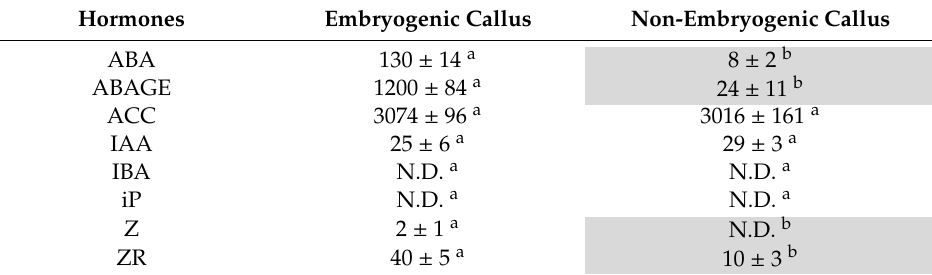
Table 7. Hormone levels in embryogenic and non-embryogenic